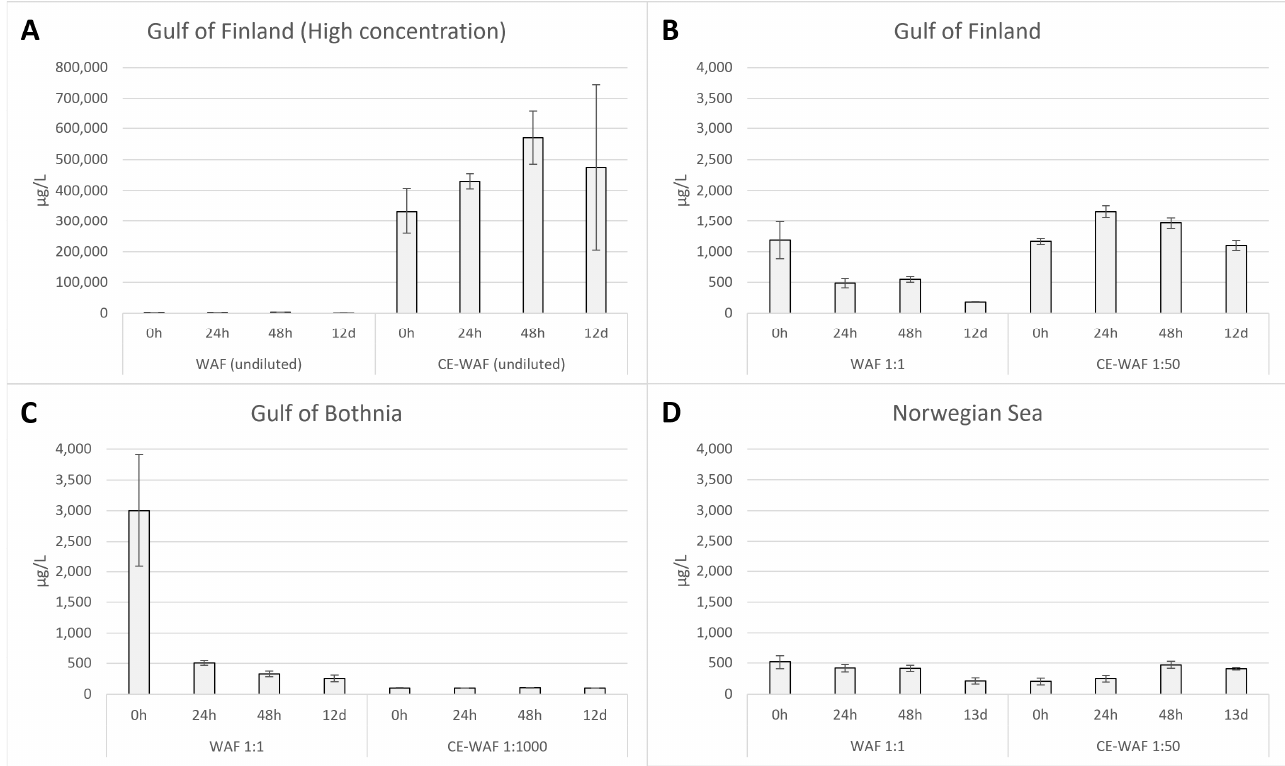
Figure 2. Petroleum hydrocarbon (C 10 -C 40 ) concentrations in microcosm experiments with different seawaters ( A – D ). Different dilutions used with WAF (without dispersant) and CE-WAF (with dispersant) are presented below the graph; also note that figures have different scales. Shown are mean values (n = 3), and error bars indicate standard deviation. Control samples consisting only of seawater analysed at the beginning of each experiment were always below the limit of detection (<100 µg/L).